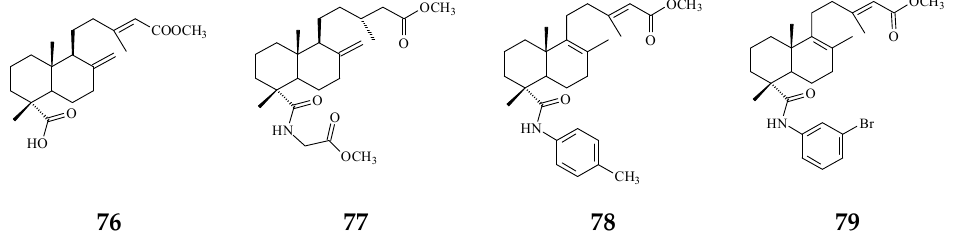
Figure 7. The synthetic compounds from (4S,9R,10R) methyl 18-carboxy-labda-8,13( E )-dien-15-oate (76) pose anti-ulcer activity. (76–79).